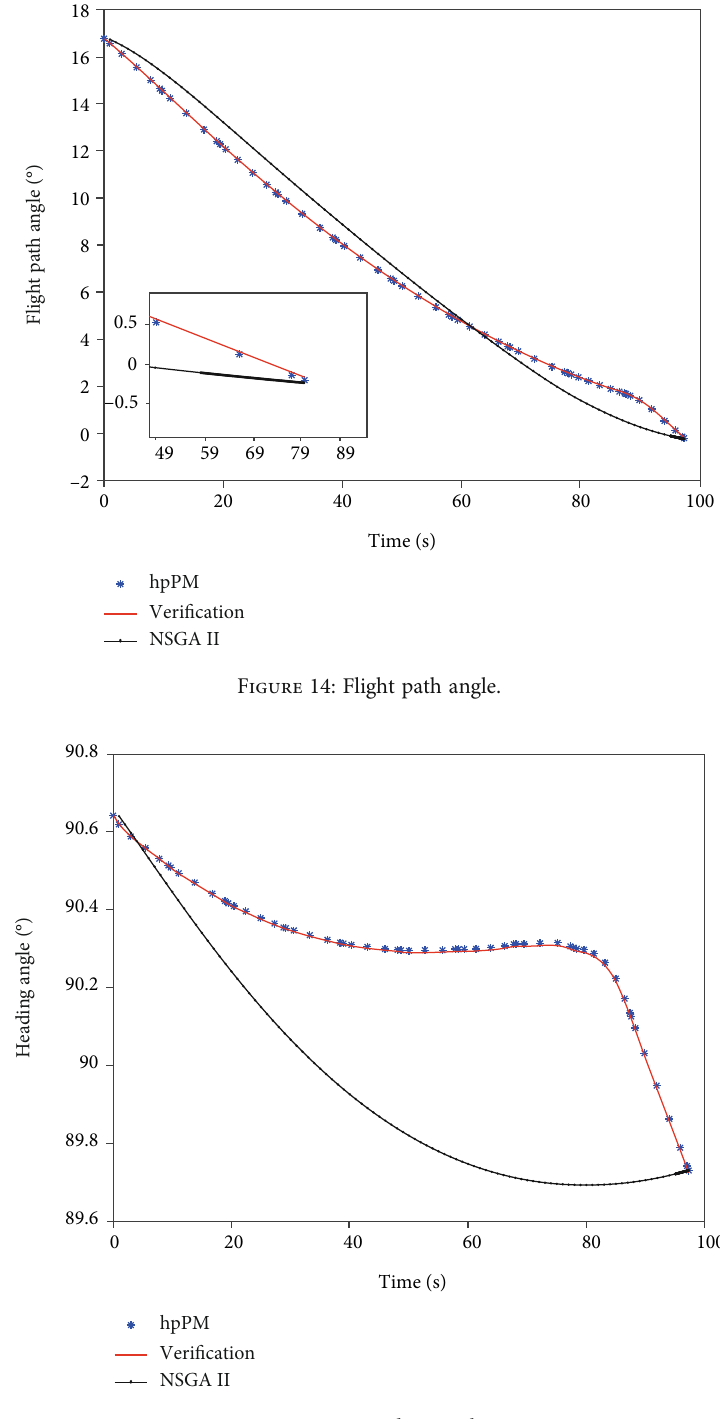
Figure 15: Heading